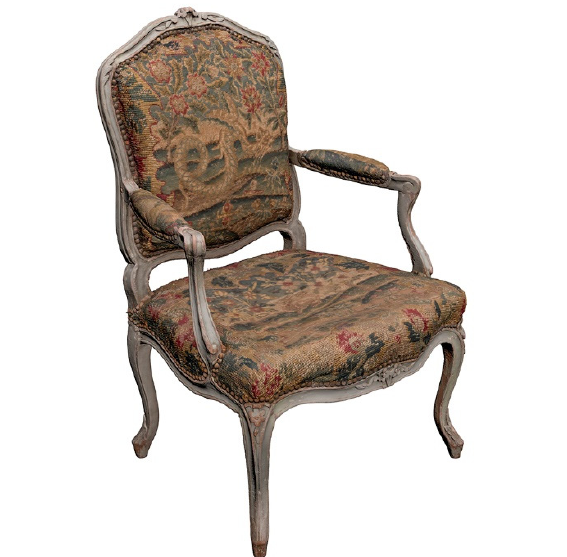
Figure 1. A historic chair with arm rests - 3D